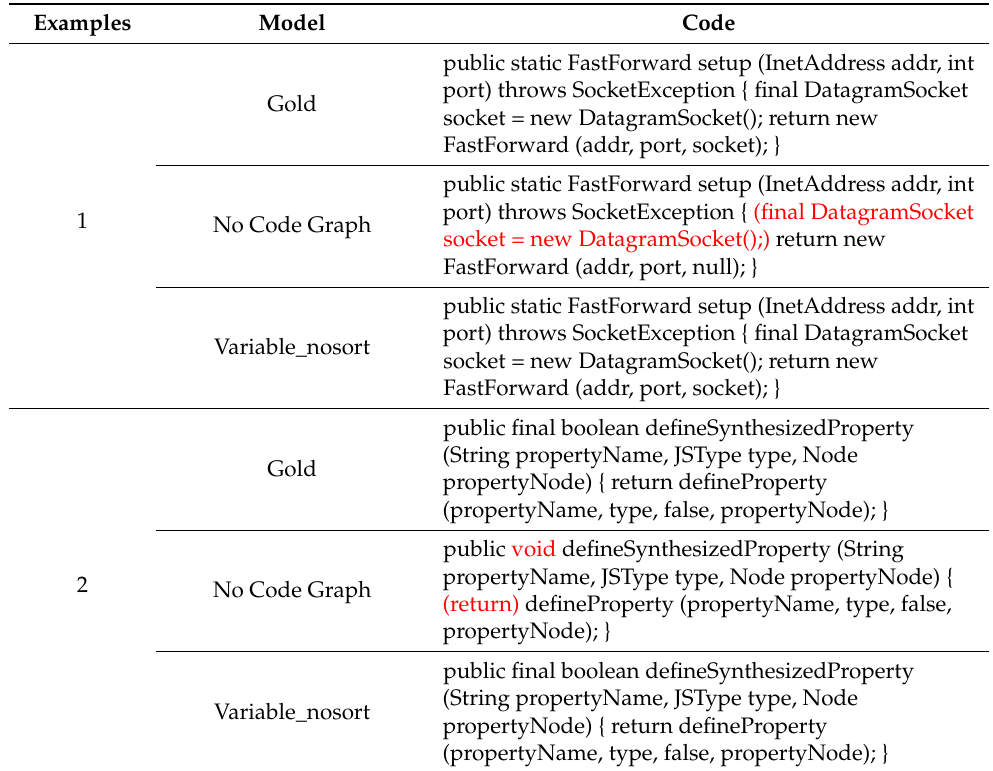
Table 12. Comparison results of the new pre-trained model with and without code graph.